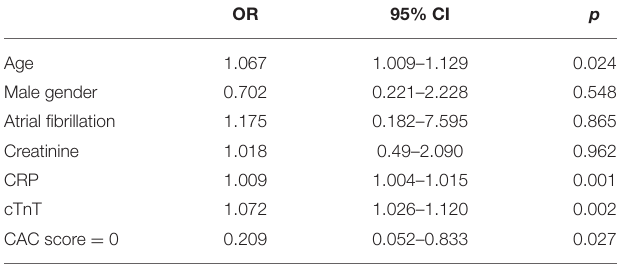
TABLE 2 | Predictors of